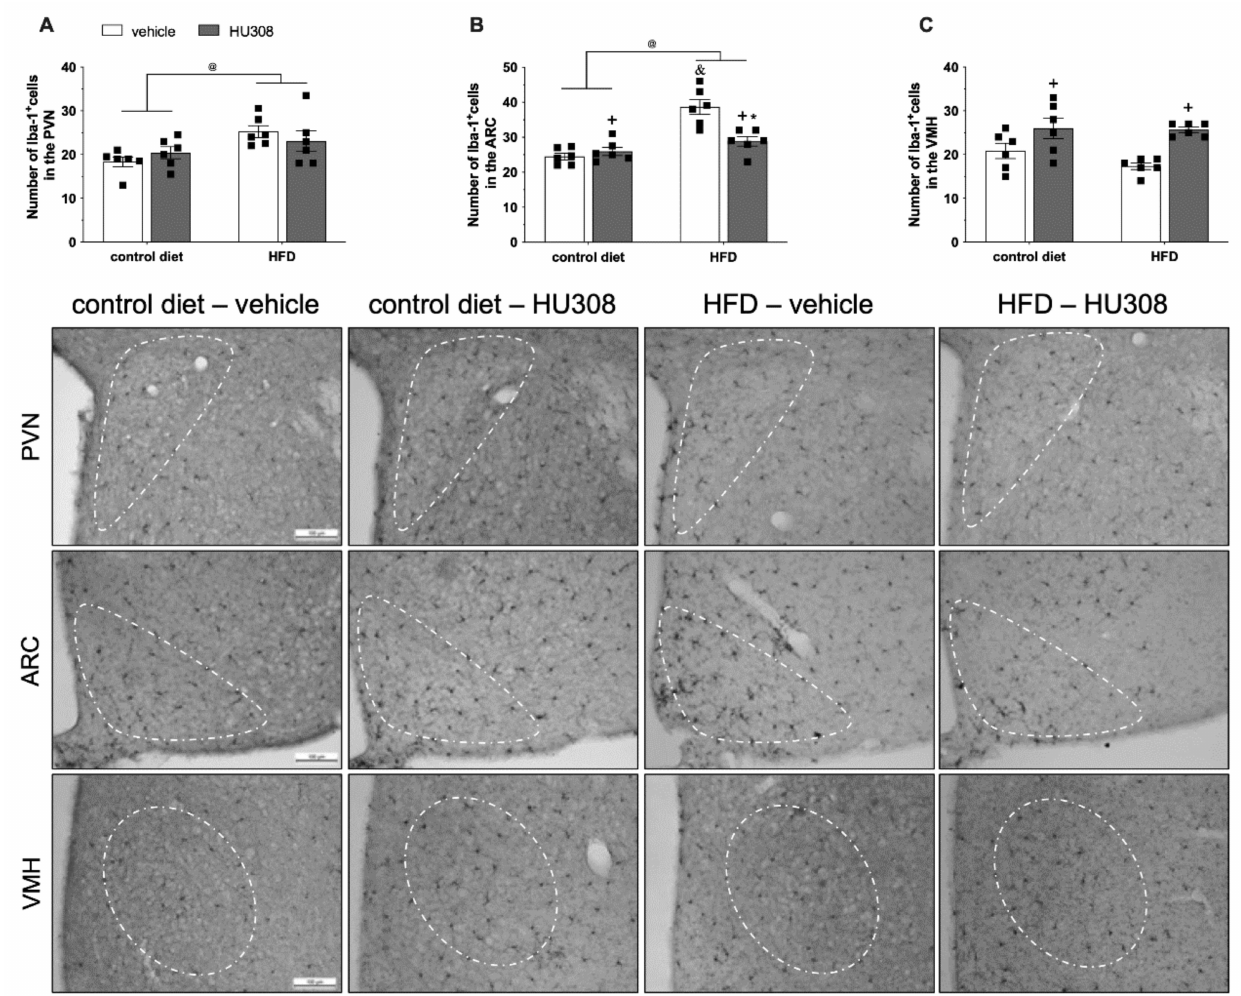
Figure 2. Effect of prolonged icv infusion of vehicle or HU308 for 2 weeks on the number of Iba-1+ cells in the paraventricular (PVN), arcuate (ARC) and ventromedial (VMH) nuclei in animals fed a control diet or high-fat diet (HFD). Number of Iba-1+ cells in the PVN ( A ), ARC ( B ) and VMH ( C ) nuclei in animals fed a control diet or HFD that received icv injection of vehicle or HU308. The data are expressed as the mean ± SEM; n = 6 per group. Data were analyzed by two-way ANOVA followed by Tukey’s post-hoc test. @ p < 0.05 (effect of diet), + p = 0.01 (effect of treatment), * p < 0.001 vs HFD+vehicle and & p < 0.001 vs control diet+vehicle. Bottom panel: Representative photomicrographs of Iba1 immunostaining in the PVN (superior panel), ARC (central panel) and VMH (inferior panel) of control diet-fed or HFD-fed animals treated with vehicle or